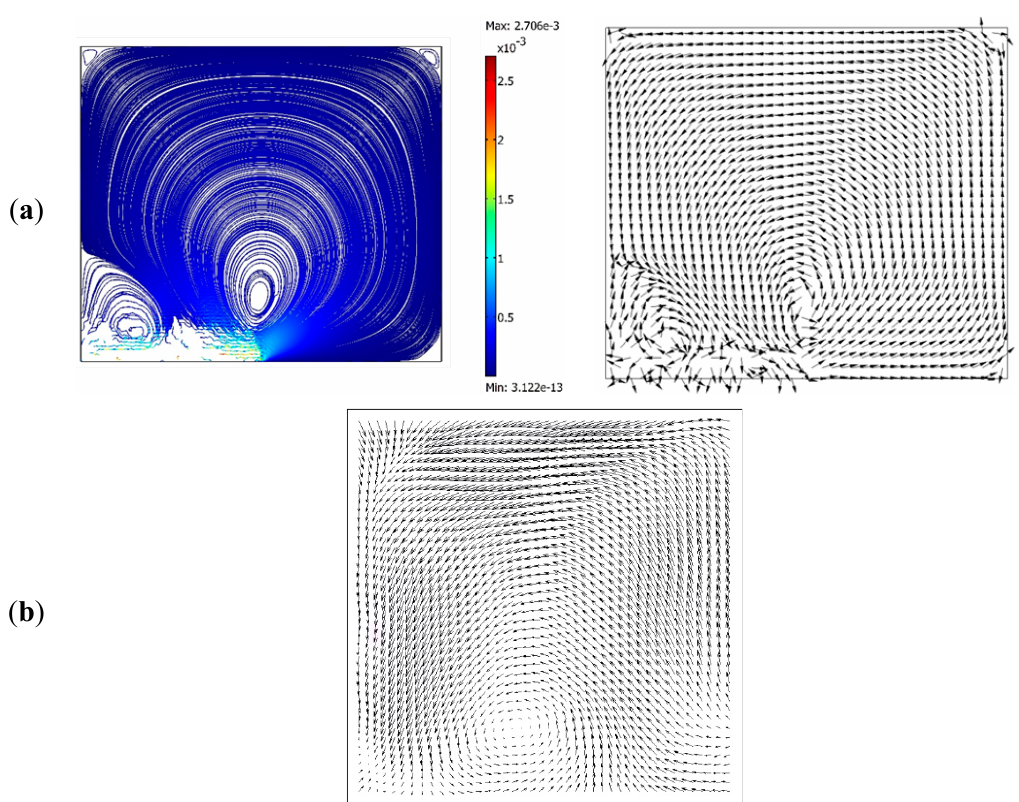
Figure 6. ( a ) Velocity magnitude (m/s) with streamlines ( left ) and flow vectors ( right ), in the 8 mm width × 7 mm height cuvette with one 4 mm length transducer, considering a 24 Vpp and 34.2 MHz oscillatory excitation, after a stationary simulation of the second order Navier- Stokes equations. ( b ) Experimental flow vectors obtained in